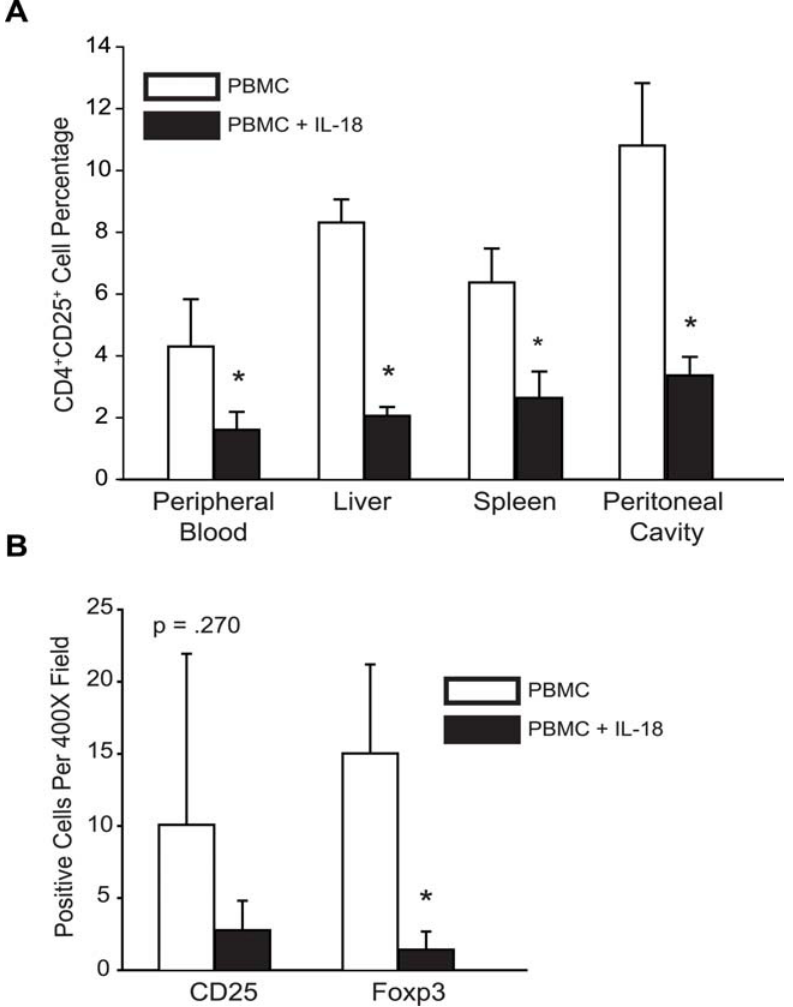
Figure 2. Human IL-18 Mediates a Decrease in Tregs in NOD/ scid/ b 2 m null mice Injected with Human PBMCs . 5 6 10 7 PBMCs were transferred into NOD/ scid / b 2M null mice. The day following cell injection, a three week course of subcutaneous huIL-18 injections was initiated. Animals in the experiment depicted in panel A received twice-weekly doses of 15 m g pegylated human IL-18, while the animals in the experiments depicted in panel B received daily doses of 15 m g recombinant human IL-18. (A) At the end of IL-18 treatment, cells isolated from the peripheral blood, peritoneal cavity, spleen and liver were stained with antibodies to human CD45, CD4, and CD25 and analyzed by flow cytometry. The mean percentage of CD + CD25 + cells from each tissue is depicted. Filled bars represent values obtained from IL-18-treated animals; open bars represent values obtained from mock-treated animals. (B) Paraffin sections from the spleens of mock- or IL-18-treated animals were reacted with antibodies specific for human CD25 or Foxp3 . Antibody-reactive cells per 400X field were enumerated blindly, and the mean 6 s.d. depicted. Solid bars depict sections from IL-18-treated animals, while open bars represent sections from mock-treated animals. The experiment in panel A was performed 2 times, and the experiment in panel B was performed 6 times. Asterisks indicate significant differences between mock- and IL-18-treated